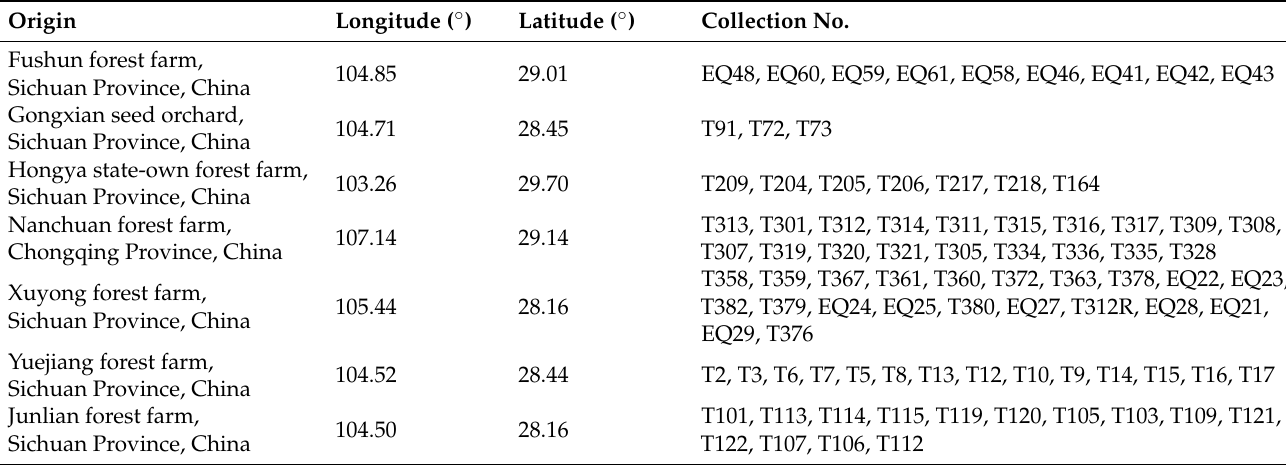
Table 1. Information of clones in the second-generation clonal seed